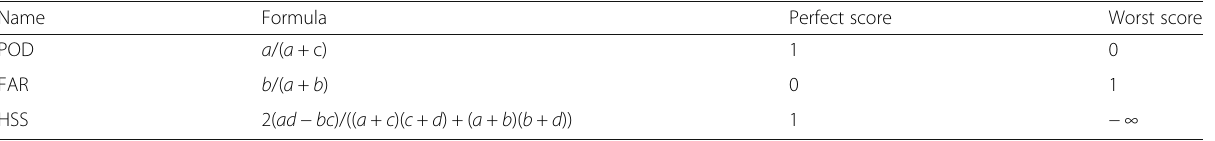
Table 4 Summary of the statistics, POD, FAR and HSS, used in this study. They are computed from counts (letters a – d ) in a 2 × 2 contingency table ( N = 1078 in TI case, N = 1148 in NM case). a SPD rainfall > threshold, VnGP rainfall > threshold; b SPD rainfall >